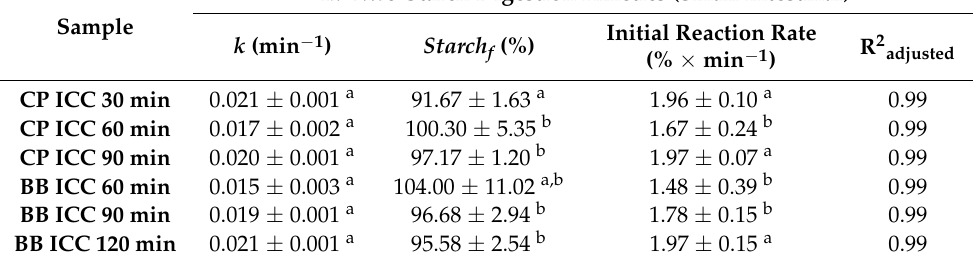
Figure 8. In vitro starch ( A1 , B1 ) and protein ( A2 , B2 ) small intestinal digestion kinetics of individ- ual cotyledon cells (ICC) from chickpea (CP) ( • ) ( A ) or black beans (BB) ( (cid:78) ) ( B ) obtained after different hydrothermal treatment times (CP: 30, 60, or 90 min; BB: 60, 90, or 120 min). Symbols represent experimental values, while lines represent values predicted by a fractional conversion model (Equation (4)). Table 4. Estimated kinetic parameters ± standard deviation of in vitro starch digestion of individual cotyledon cells (ICC) from chickpea (CP) or black bean (BB) aligned to equivalent hardness levels using hydrothermal treatment for 30, 60, or 90 min and 60, 90, or 120 min, respectively. Starch digestion kinetic parameters were estimated by fitting the experimental data to a fractional conversion model (Equation (4)). Mean values (within a column) with different superscript letters are significantly different based on 95% confidence